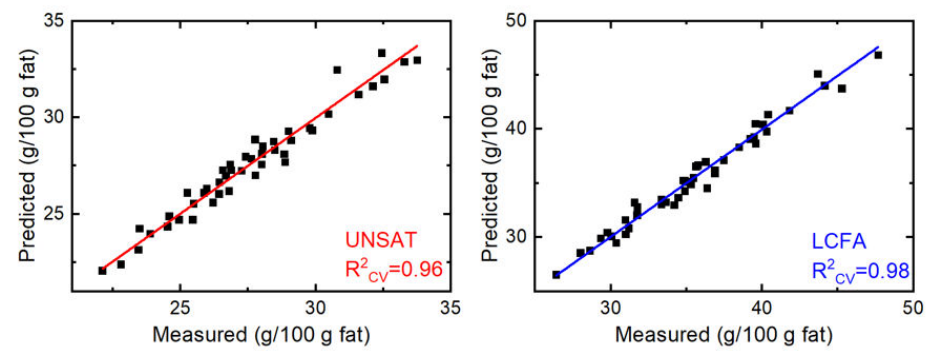
Figure 2. Relationship between measured (GC/MS) and predicted (cross-validation, FT–IR) fatty acid content in g/100 g fat for unsaturated fatty acids (UNSAT, left ) and long-chain fatty acids (LCFA, right